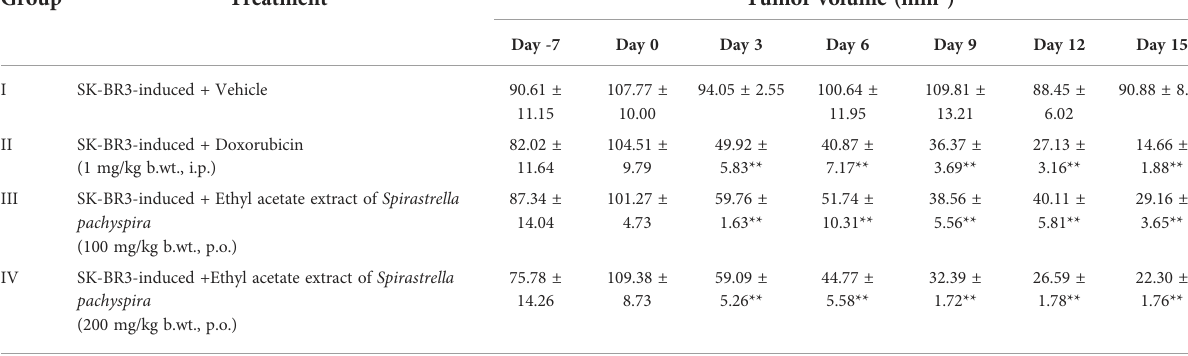
TABLE 4 The effect of ethyl acetate extract of Spirastrella pachyspira on tumor volume of athymic mice bearing s.c. SK-BR-3 tumor. Group